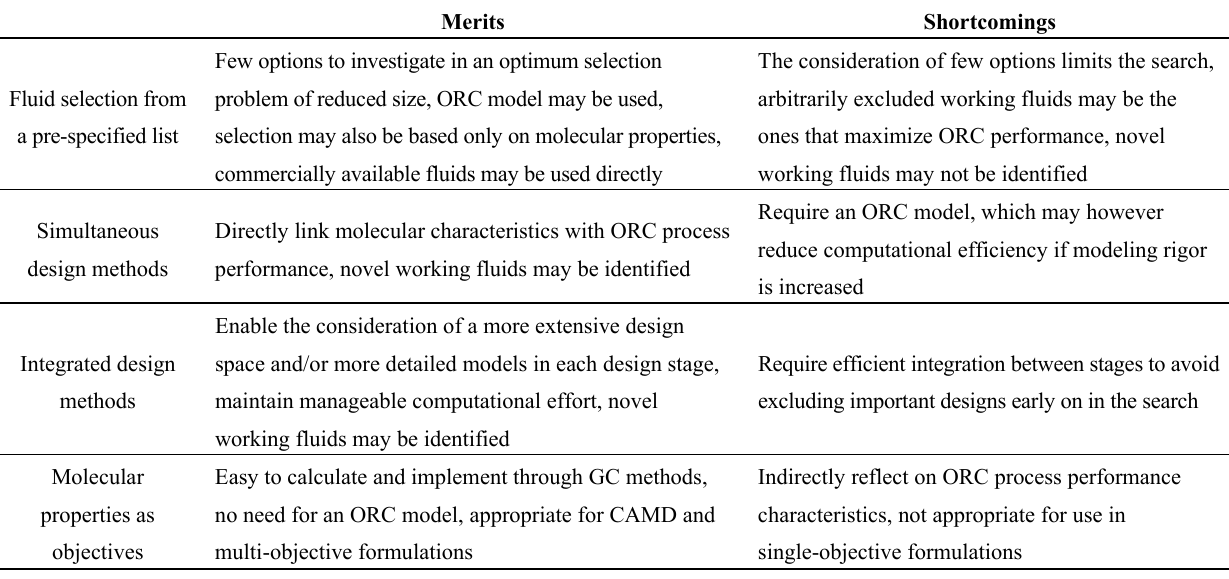
Table 3. Merits and shortcomings of considered methods and objective functions in fluids